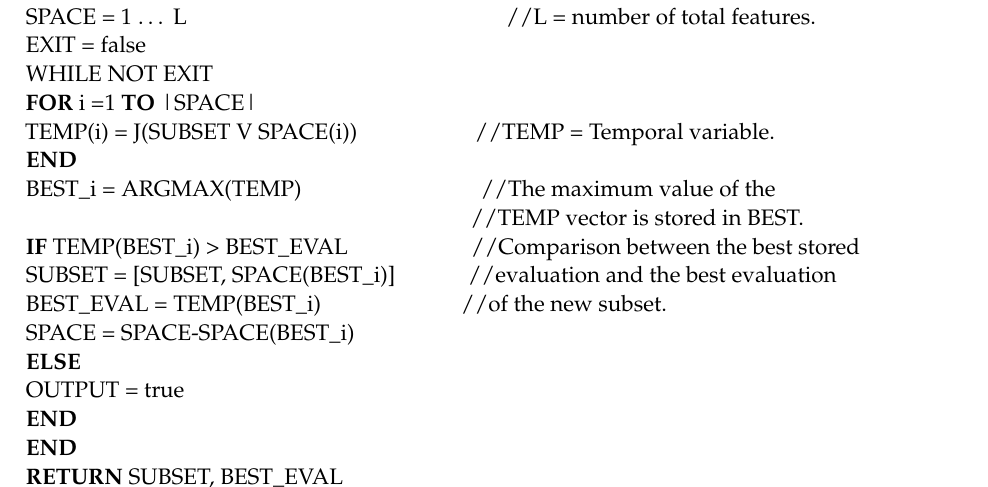
Algorithm 2 Pseudocode Implemented for forward Sequential